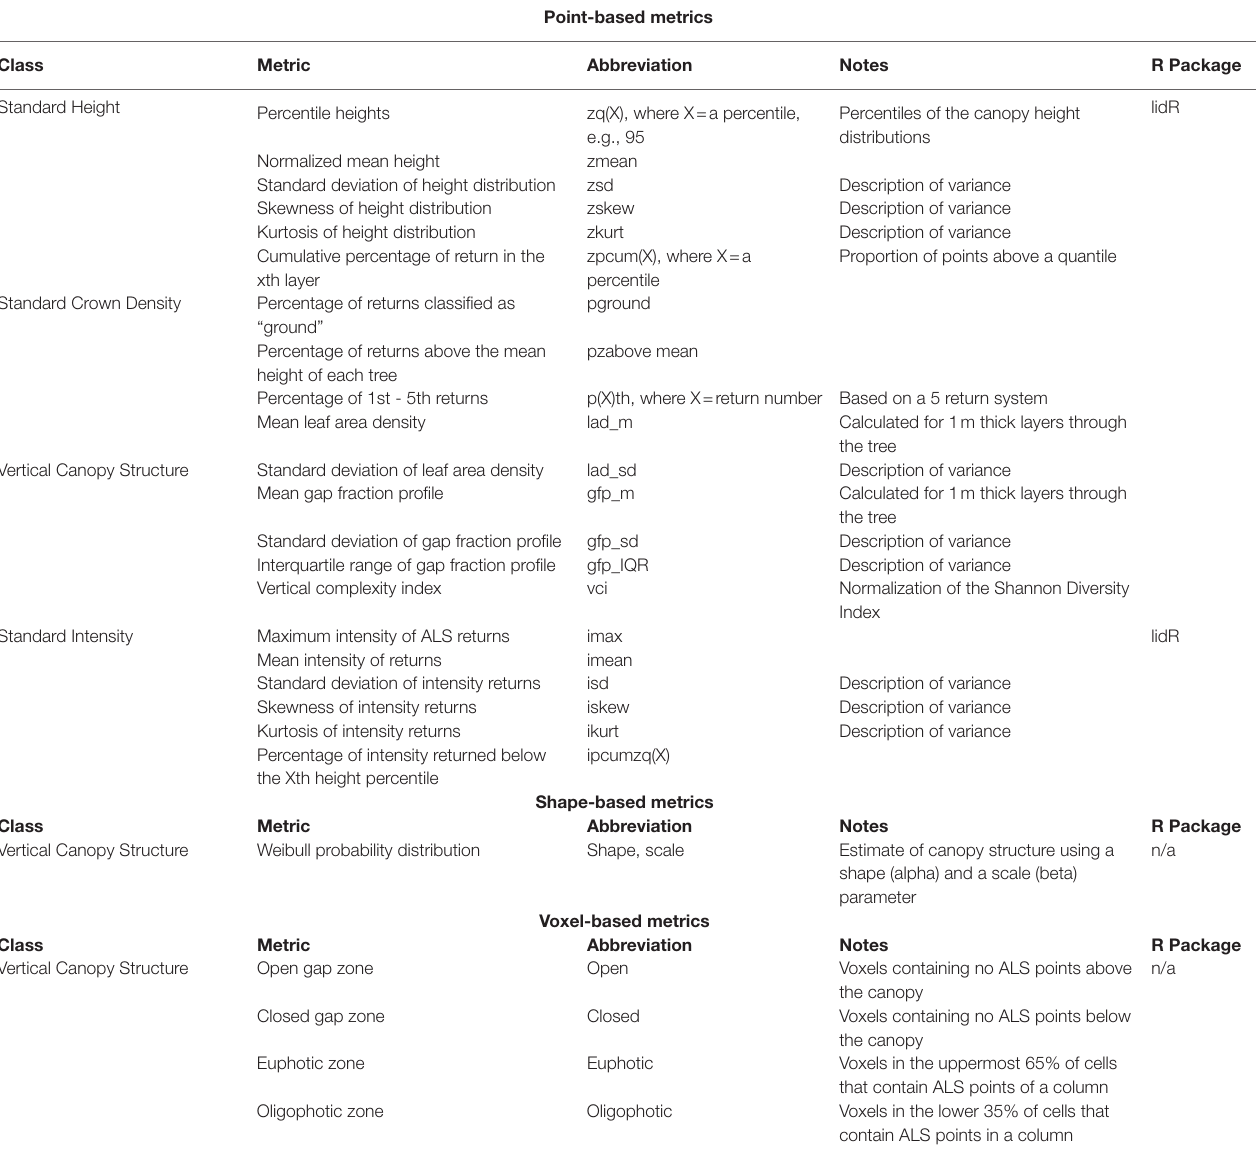
TABLE 3 | Summary of candidate metrics and their abbreviations produced for ALS-derived trees, including relevant R packages.